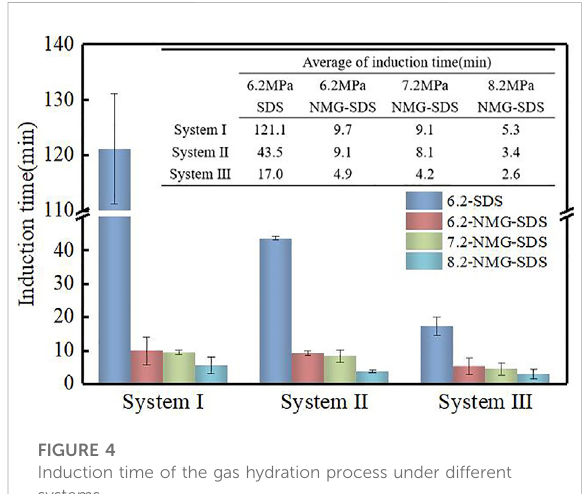
FIGURE 4 Induction time of the gas hydration process under different